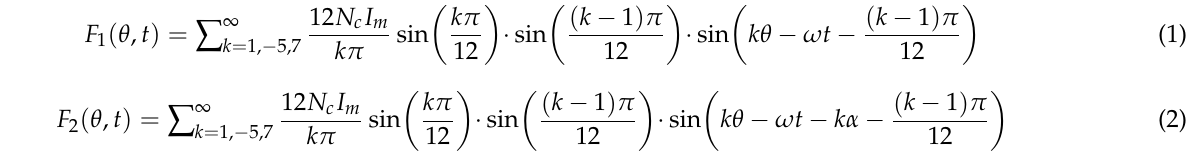
Figure 2. Maximum torque performance of the reported FIPMSM with N42UH Nd-Fe-B PM and NMF-12G ferrite PM and proposed SIPMSM with NMF-12G ferrite PM. NMF-12G ferrite PM and proposed SIPMSM with NMF-12G ferrite